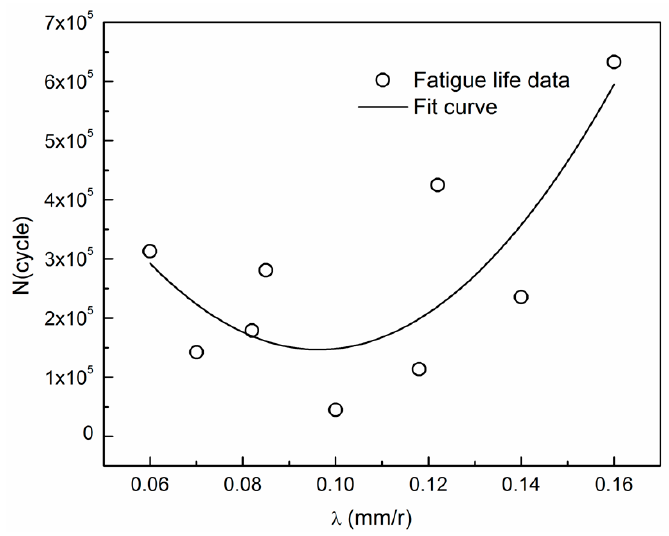
Figure 8. Correlation between advancing pitch and fatigue life.